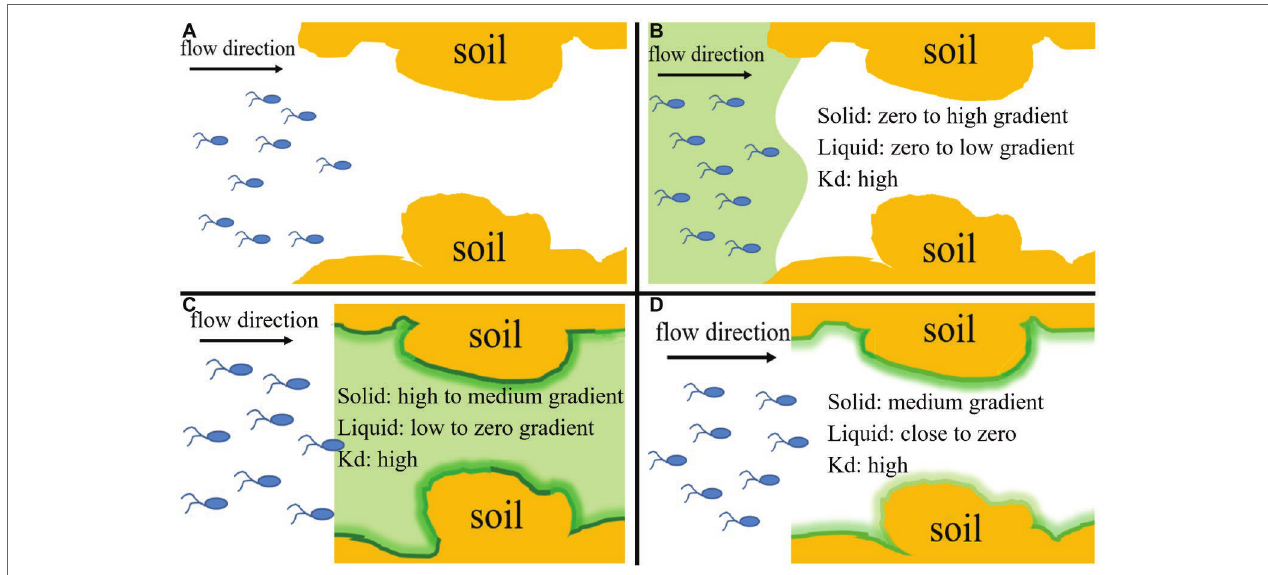
FIGURE 4 | Conceptual diagram of four input modes of naphthalene and bacteria, which represent their different co-existence situations and different distribution ratios of naphthalene between immobile solid phase and mobile liquid phase within the columns during transport process and allow evaluation of the relative importance of chemotaxis and haptotaxis to bacterial transport. (A) Input Mode 1: injection of bacteria only (10 pore volumes), (B) Input Mode 2: co-injection of bacteria and naphthalene (10 pore volumes), (C) Input Mode 3: injection of naphthalene (20 pore volumes) immediately followed by injection of bacteria (10 pore volumes), (D) Input Mode 4: injection of naphthalene (20 pore volumes) followed by a flush with background solution (15 pore volumes) and then injection of bacteria (10 pore volumes). K d is the partition coefficient of naphthalene between the solid phase and aqueous phase. The ‘“High”, “medium” and “low” refer to general’ concentration gradients of naphthalene in solid and liquid